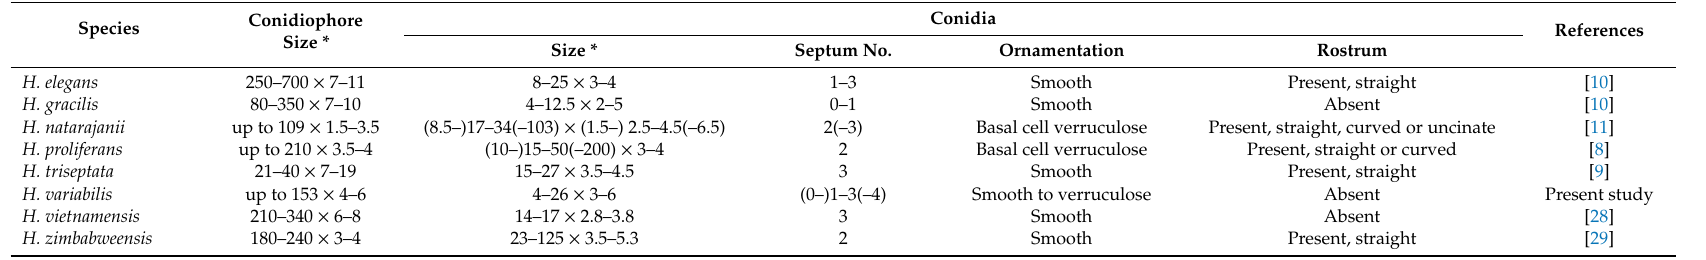
Table 2. Key morphological features distinguishing the accepted Heliocephala species.